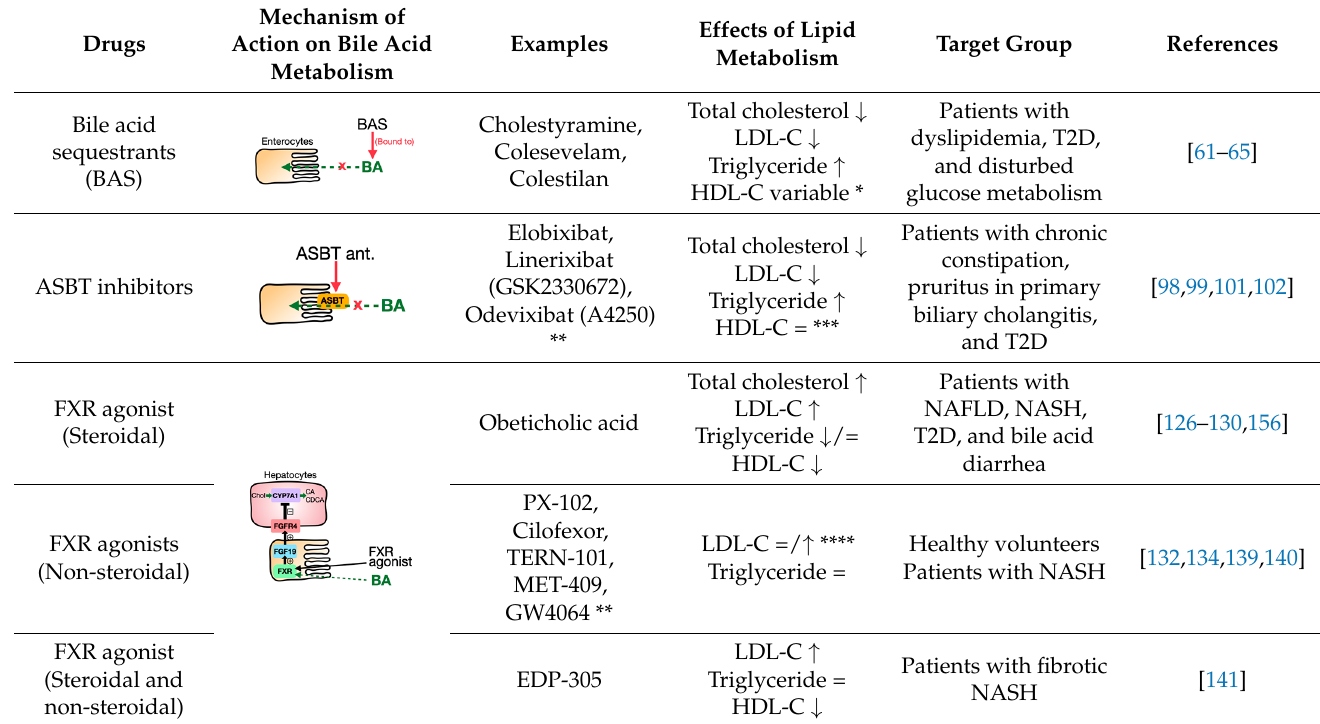
Table 2. Clinical interventions on lipid metabolism by regulating bile acid metabolism.